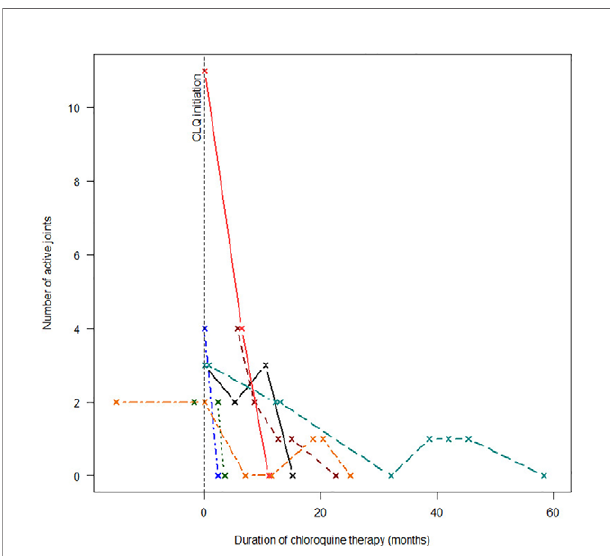
FIGURE 2 | Response to chloroquine therapy.